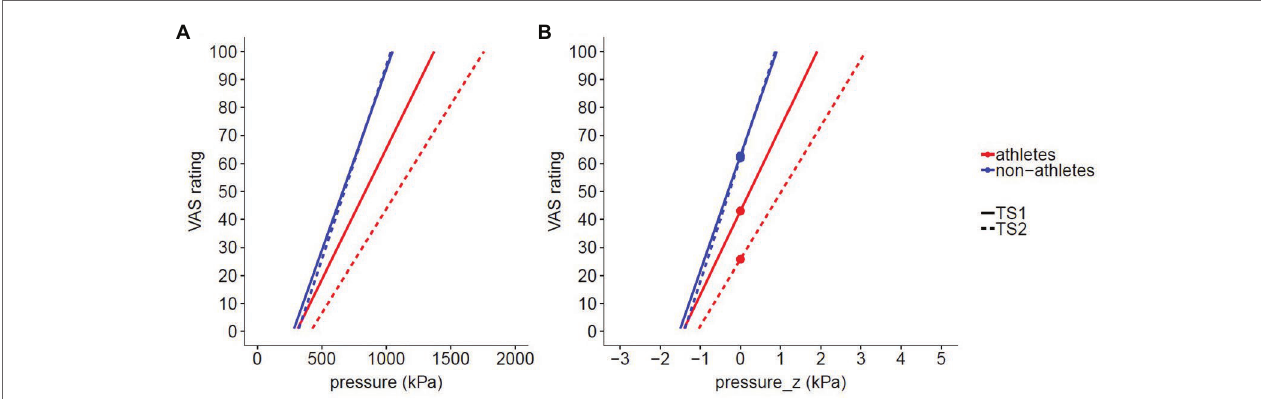
FIGURE 5 | Stimulus response functions (SRF) of pressure pain. (A) Original data of SRF of pressure pain applied immediately before (TS1) and after (TS2) 1 min cold water immersion. (B) For multilevel data analysis, we used z -standardized pressure (for details, see description in “Materials and Methods” section). The CPM effect was defined as difference VAS TS2 − VAS TS1 during a z -standardized pressure of 0 (thick marked points). Thus, a negative value represents CPM-induced